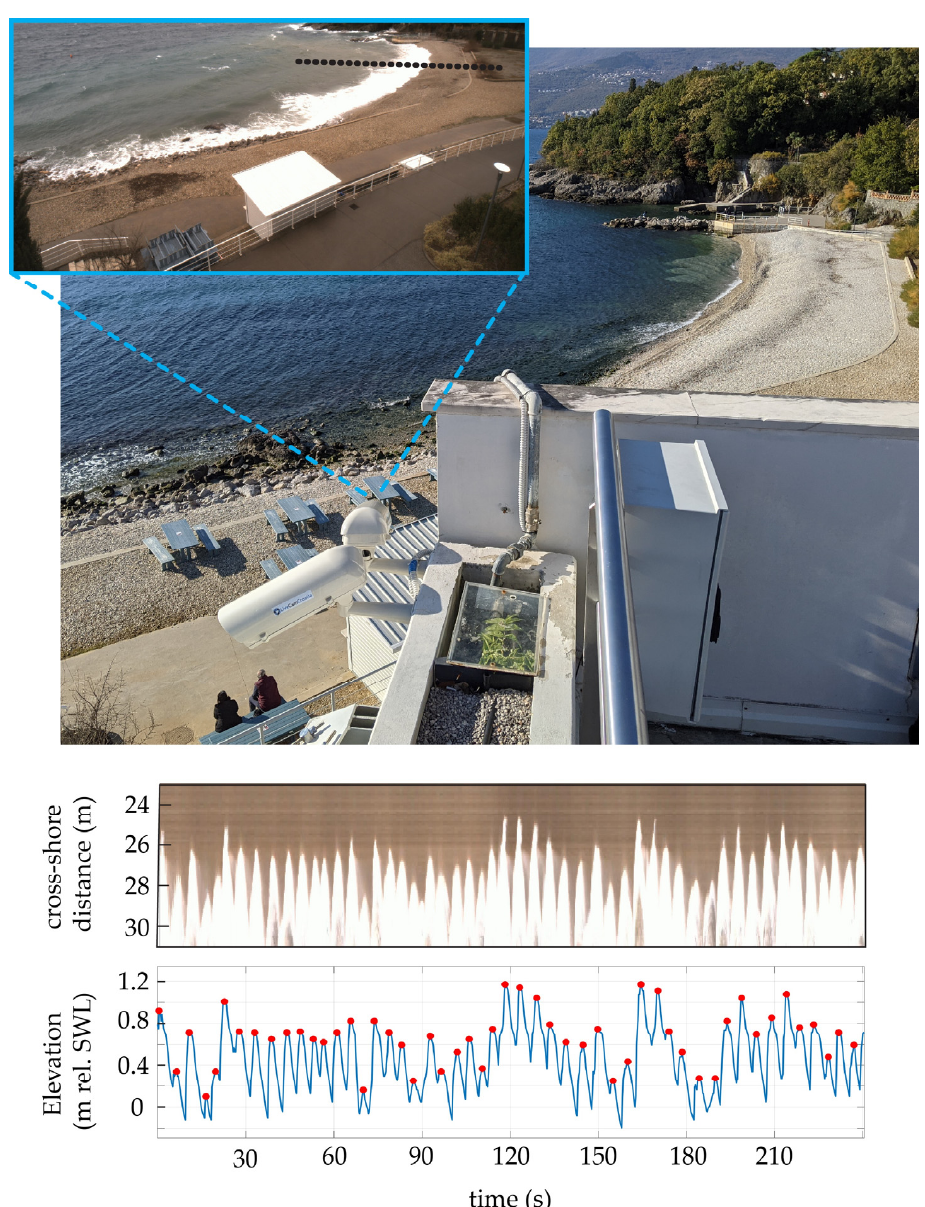
Figure 3. Position of the video monitoring system at the edge of the swimming pool complex at the beach site, one camera per beach cell; observed pixel cross-section of the acquired video gives the cross-shore distance time series of wave uprush, which ultimately results in the water elevation time series on the shoreline